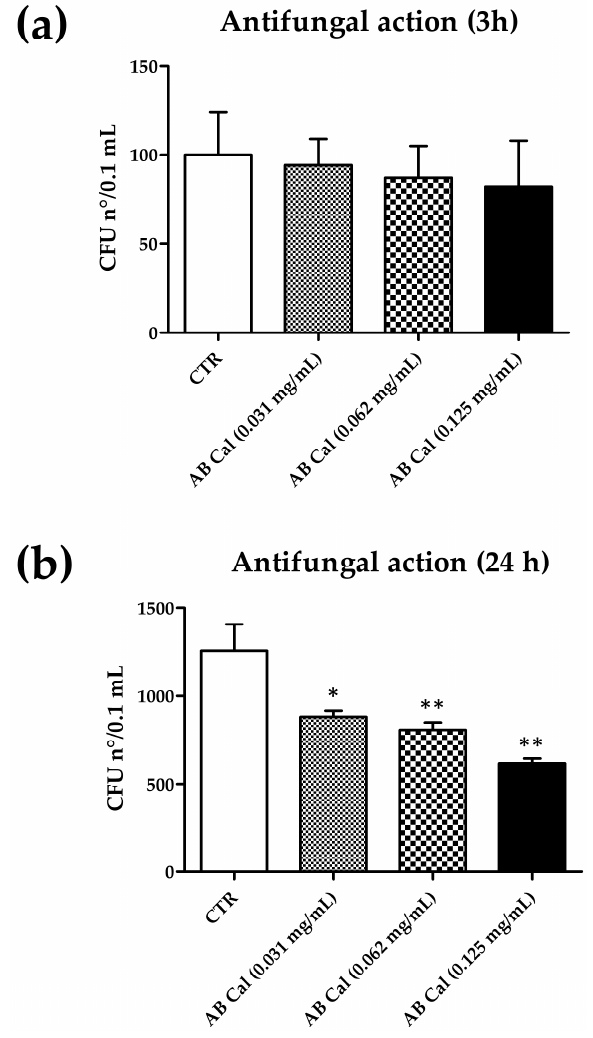
Figure 6. Antimicrobial activity of Cal peptide in aqueous buffer (AB). ( a ) Effect after 3 h of incubation; ( b ) Effect after 24 h of incubation. CTR, control yeast, receiving AB buffer without Cal; CFU, colony forming units. Results are expressed ad mean value of CFUs ± SD obtained in triplicate samples from two independent experiments; * p value ≤ 0.05; ** p value ≤ 0.01.